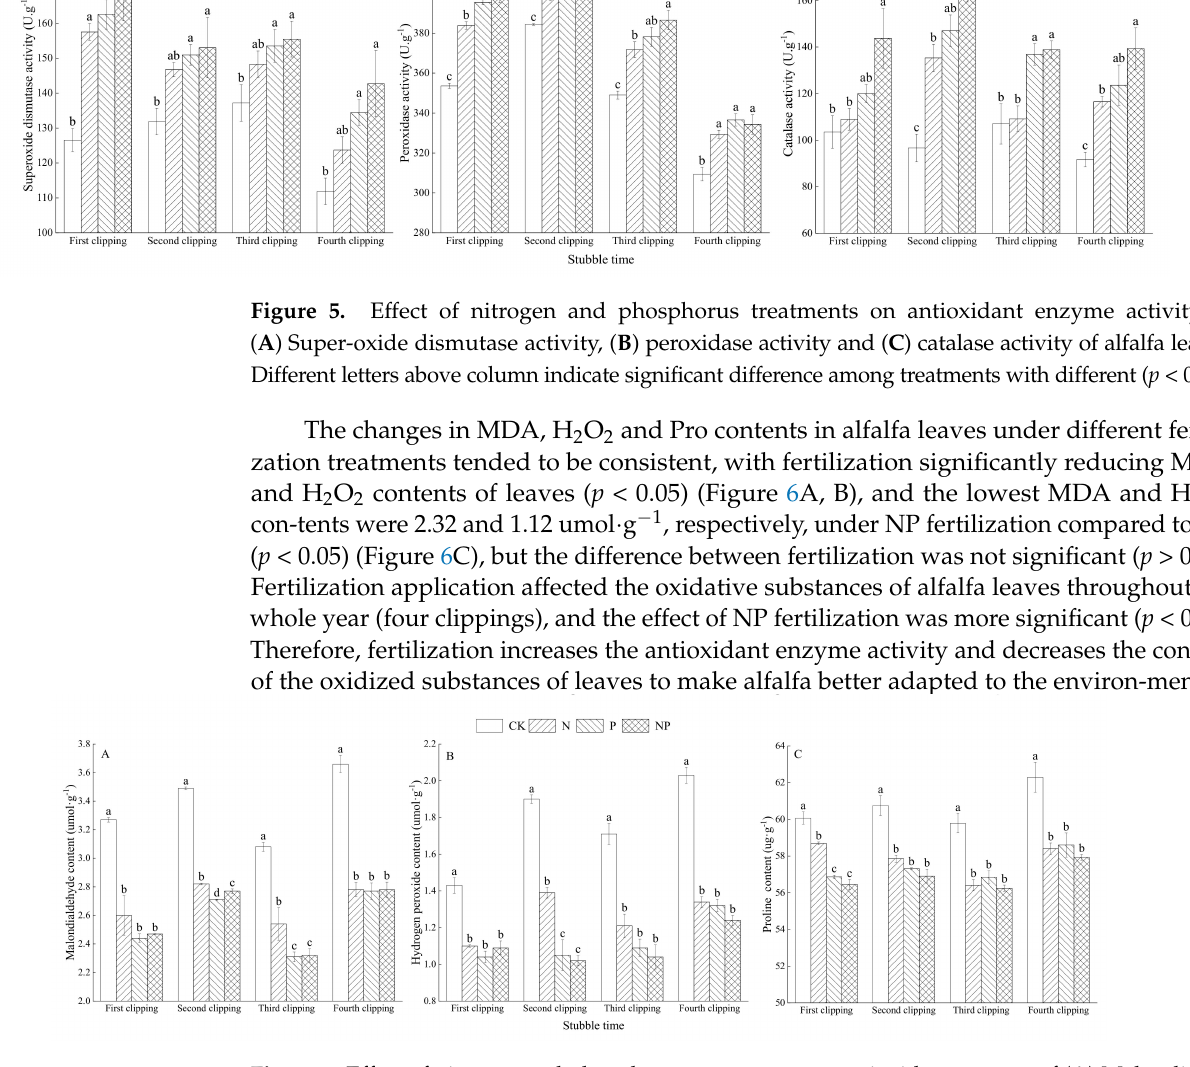
Figure 6. Effect of nitrogen and phosphorus treatments on antioxidant content of ( A ) Malondialde- hyde content, ( B ) hydrogen peroxide content and ( C ) proline content of alfalfa leaves. Different letters above column indicate significant difference among treatments with different ( p <